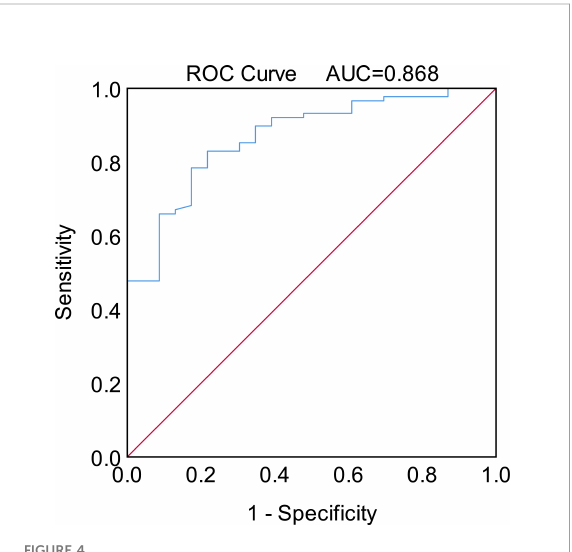
FIGURE 4 Receiver operating characteristic (ROC) curves for the predictive value of using GTVnx volume to discriminate whether the prescribed dose (60 Gy) cover at least 95% of the volume of